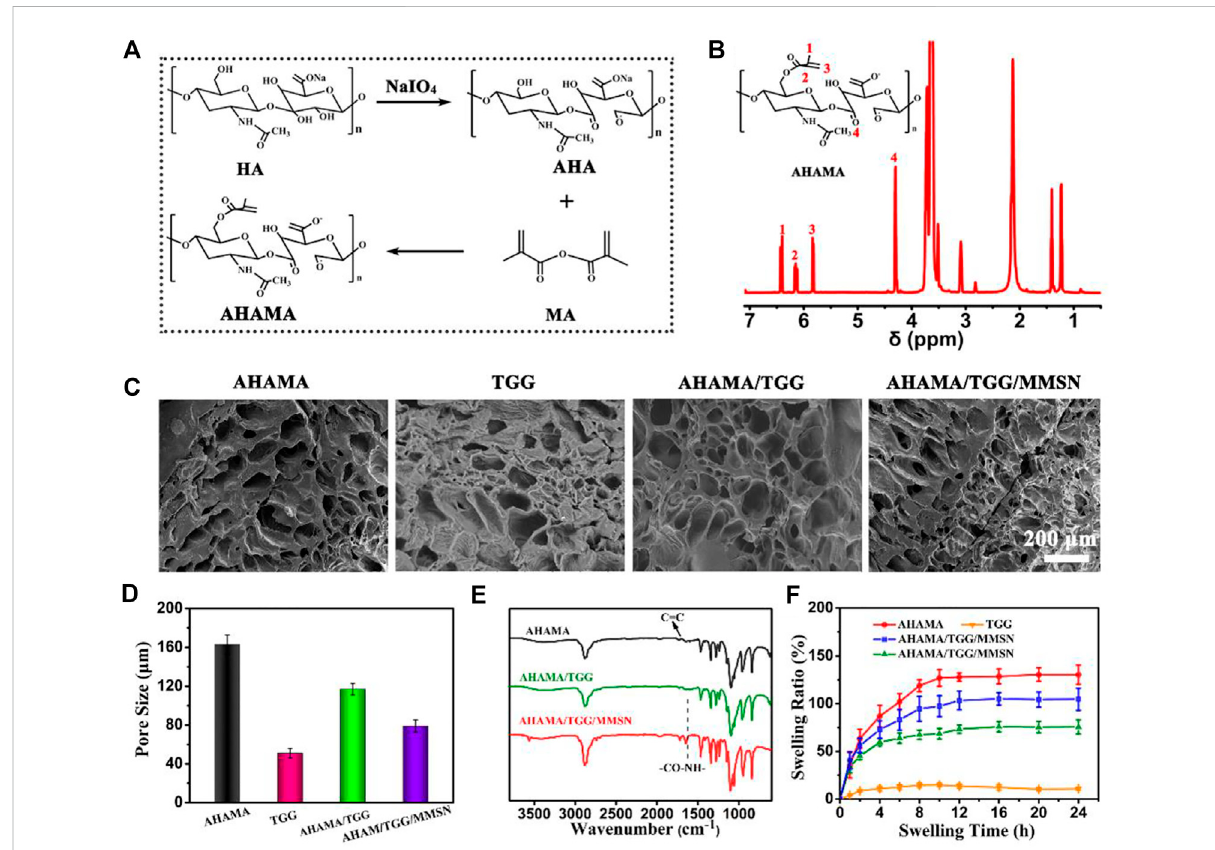
FIGURE 1 (A) Chemical synthesis of AHAMA conjugate by a two-step approach. (B) 1H-NMR analysis of AHAMA conjugate. (C) SEM images of AHAMA, TGG, AHAMA/TGG and AHAMA/TGG/MMSN hydrogels, and (D) their corresponding pore diameter. (E) FT-IR spectra of the prepared